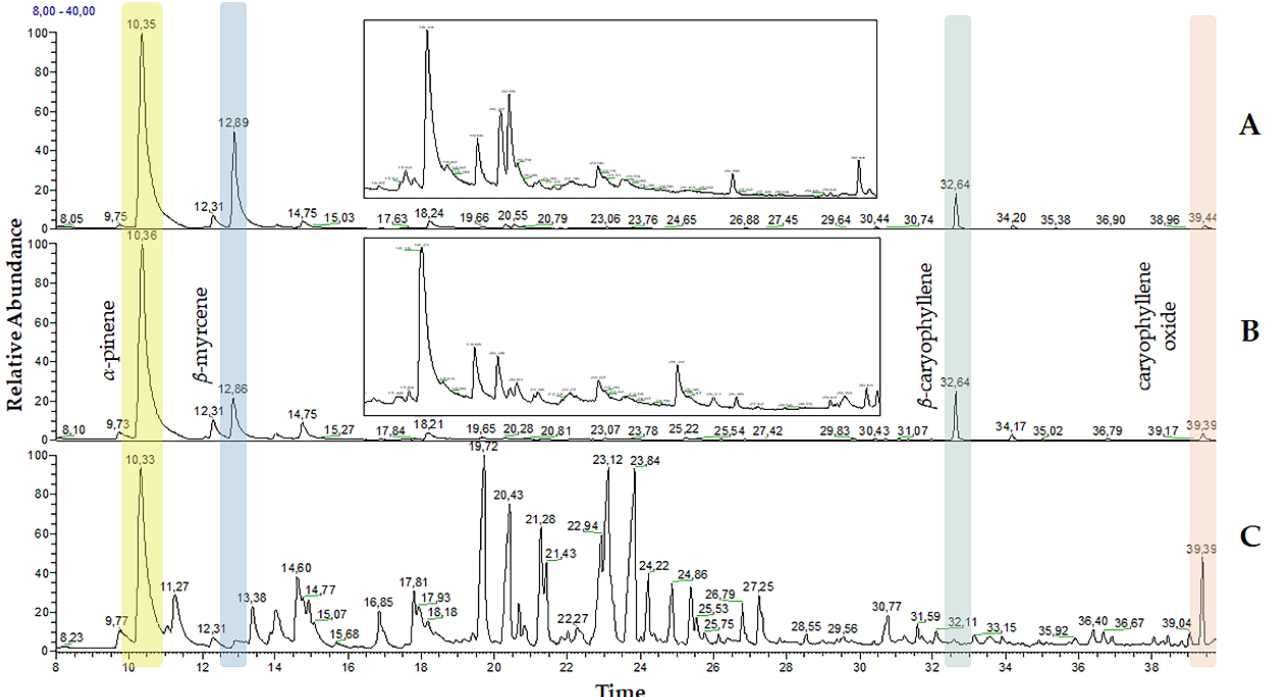
Figure 2. GC-MS chromatograms of Chios Mastic Oils (CMOs) obtained from ( A ) a fresh (CMO_1), ( B ) a 2-year-old (CMO_8) and ( C ) a 10-year-old resin (CMO_9).